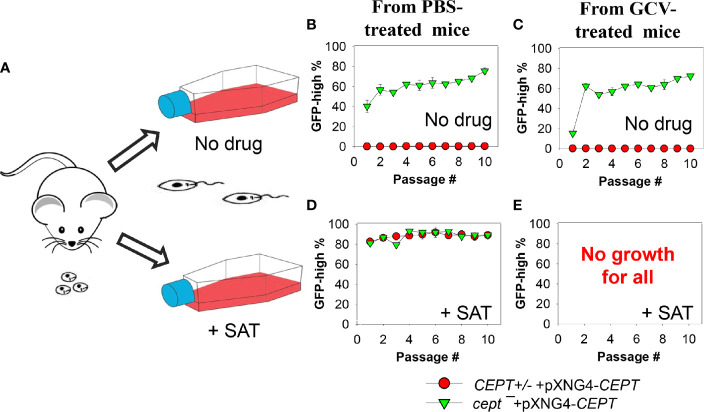

Cept ¯+pXNG4-CEPT parasites restore their episome levels after converting to promastigotes. (A) Amastigotes from infected BALB/c mice were allowed to recover in complete M199 media in the absence or presence of 200 µg/ml of nourseothricin (+ SAT). Promastigotes were then continuously cultivated in the absence (B, C) or presence (D, E) of nourseothricin for 10 passages and percentages of GFP-high cells were analyzed by flow cytometry for each passage. It is of note that no cells from GCV-treated mice were able to recover in nourseothricin (E). For (B–D), error bars represent standard deviations from two independent biological experiments (two technical duplicates each time).